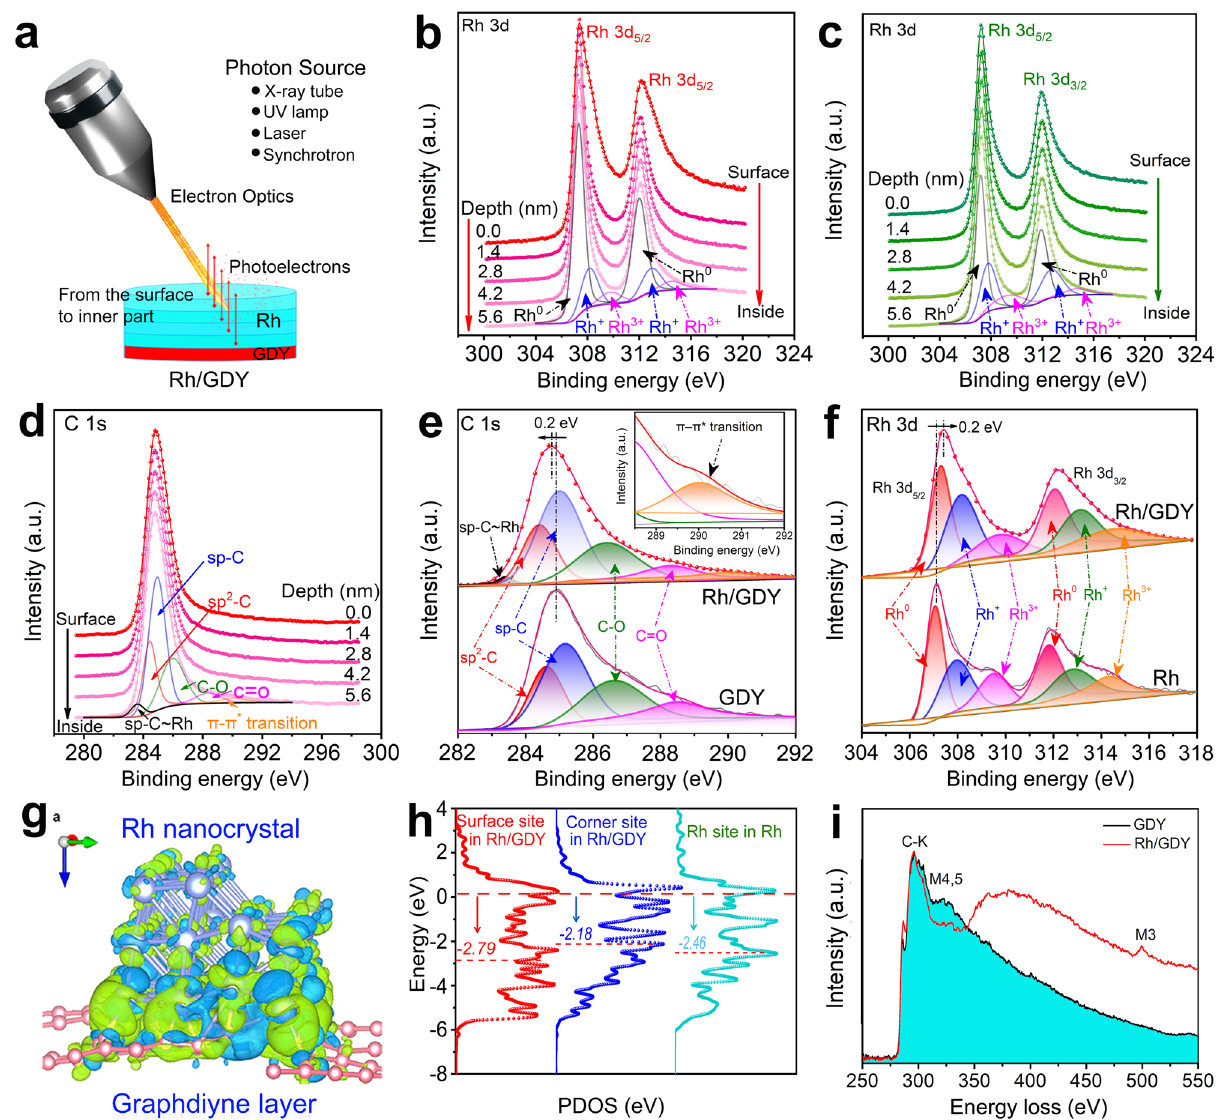
Fig. 3 | XPS and PDOS characterizations of the samples. a Schematic repre- sentation of the depth pro fi ling experiments. The sets of b , c Rh 3d obtained from different samples and d C 1s XPS spectra of Rh/GDY measured during the depth pro fi ling experiments. The high-resolution e , C 1s, f Rh 3d XPS spectra of the